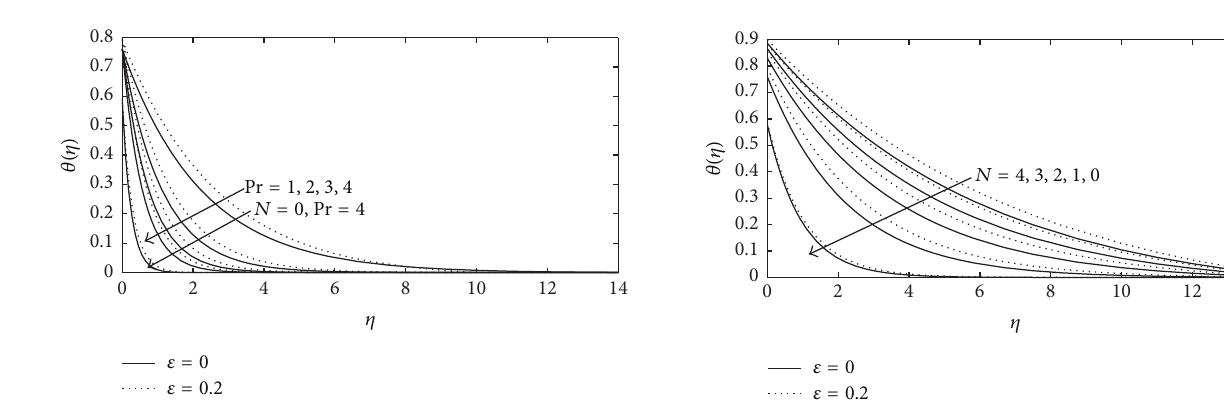
Figure 7: Effect of radiation parameter on temperature distribution when 𝐾 = 1 , 𝑊 𝑠 = −1 , Re = 100, Kn = 0.05, and Pr =